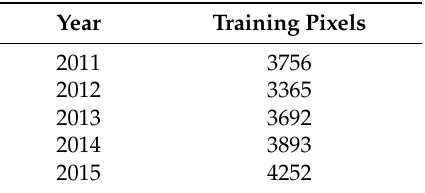
Table 4. Number of training pixels used in supervised